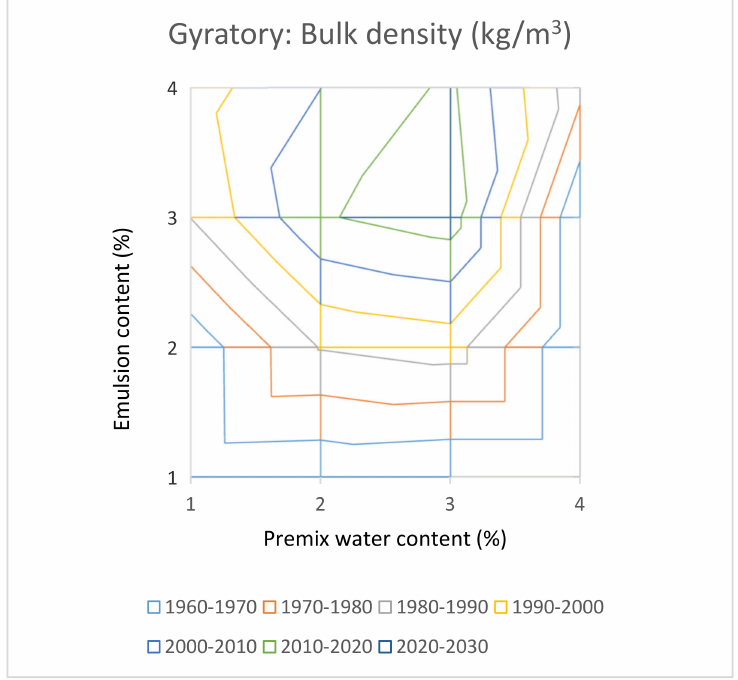
Figure 10. Bulk density for mixtures compacted with the gyratory